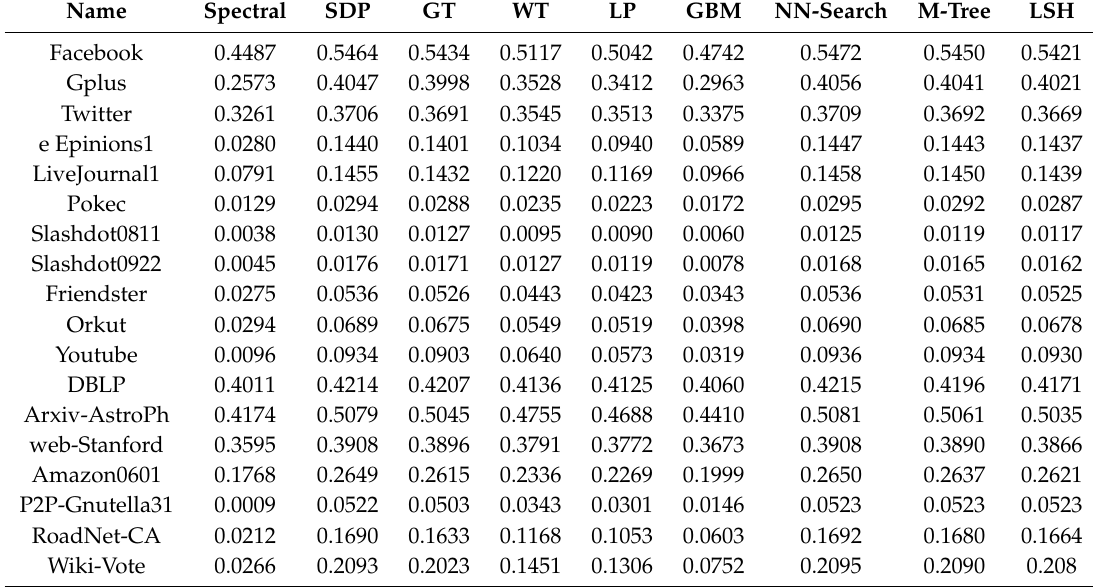
Table 5. Comparison of our approaches with other best methods in terms of modularity.